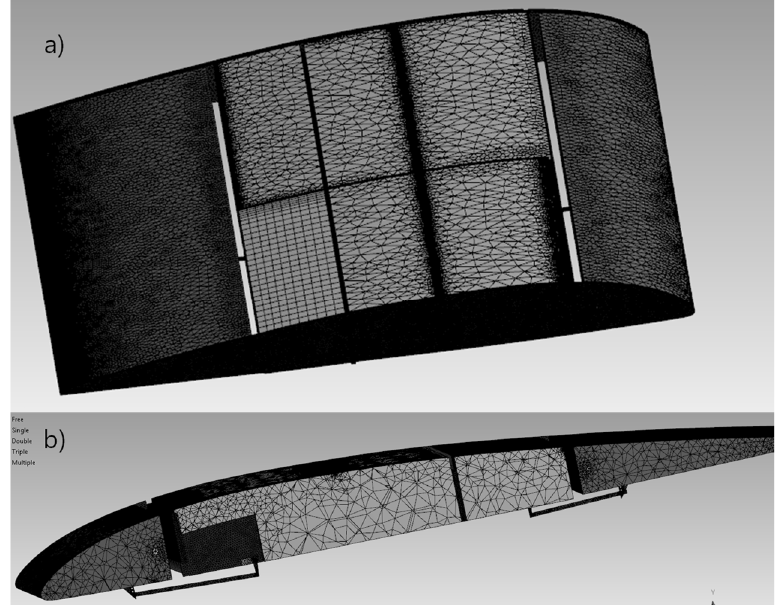
Figure 16. Mesh generation of the adaptive wing: ( a ) top view and ( b ) isometric view.